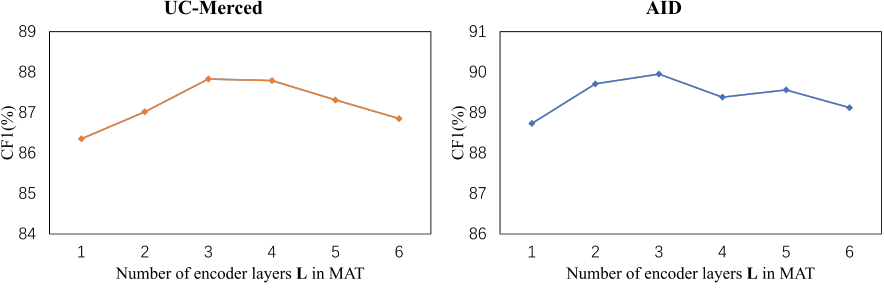
Figure 5. The results of ablation studies on the number of encoder layers in MAT.